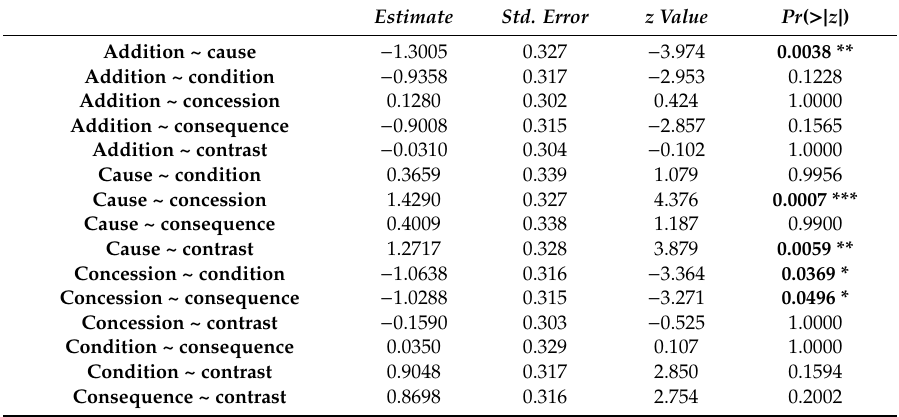
Table 7. Native speakers, di ff erences in the main task score between the tested relations. Estimate Std.